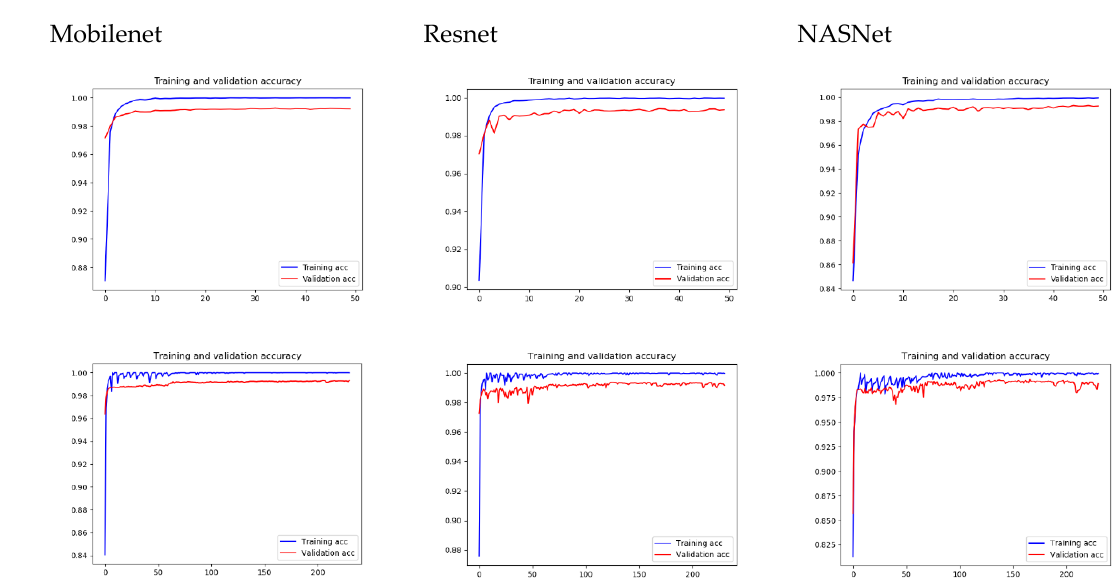
Figure 14. Performance when models were trained on the large PlantVillage dataset, using the conventional training (upper row) and YMufT strategies (lower rows).